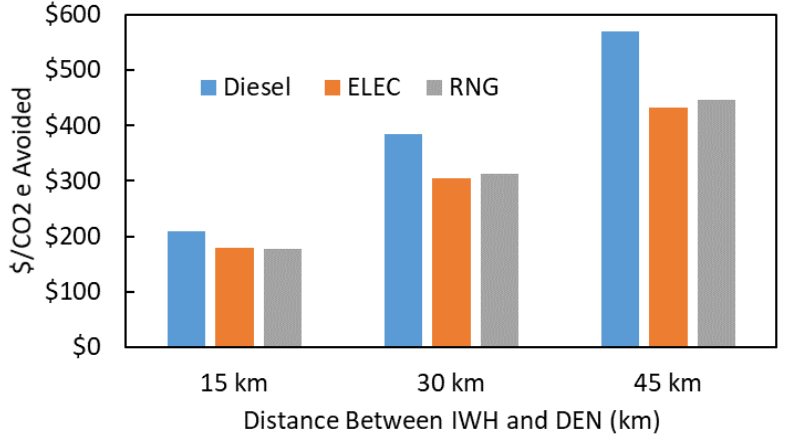
Figure 8. The cost of avoided CO 2 e with different IWH locations and truck modes.